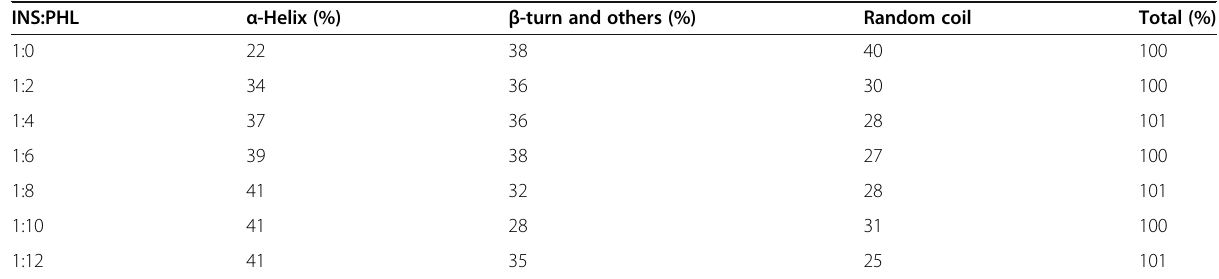
Table 5 The ratio of secondary structure between INS and different concentrations of